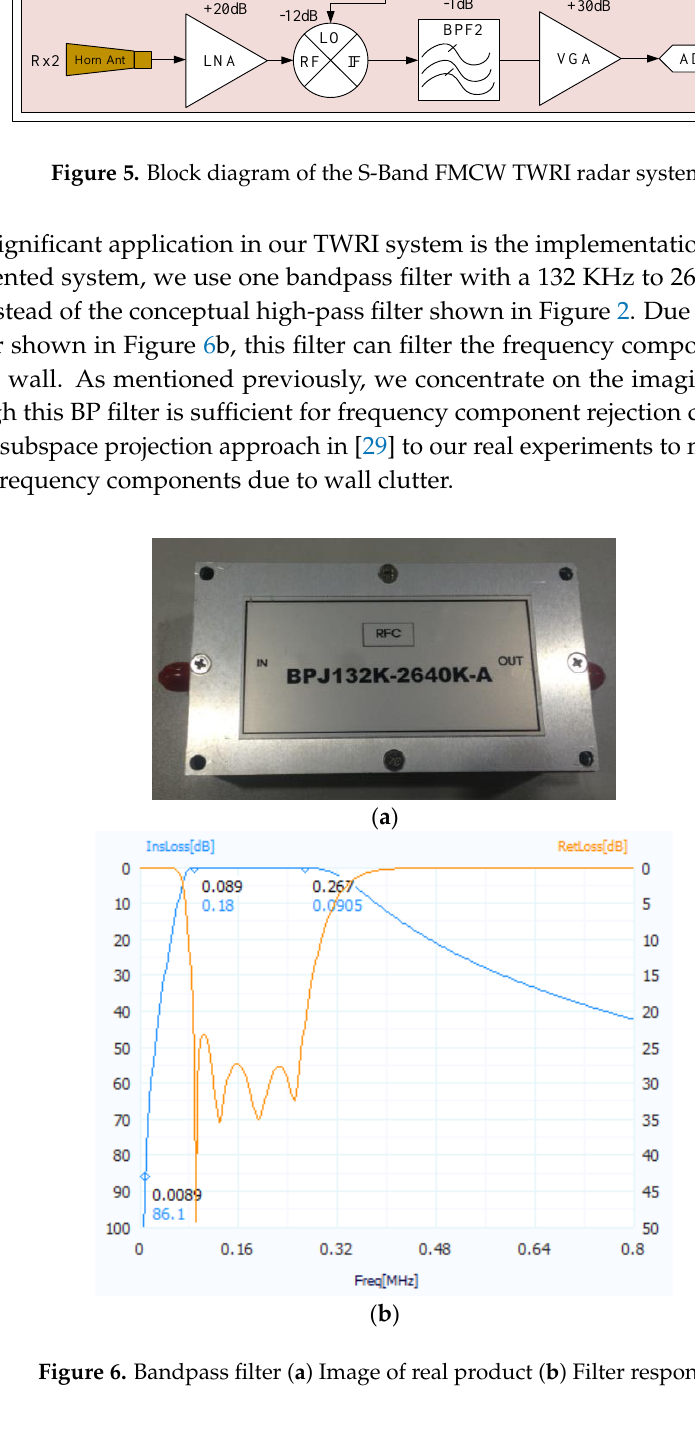
( b ) Figure 6. Bandpass filter ( a ) Image of real product ( b ) Filter response. Three identical standard horn antennas with 10 dB gain were employed in our implemented system, one for Tx (Back-end) and the others for Rx 1 and Rx 2 (Front-end), respectively. The outline and beam patterns of the standard horn antennas are illustrated in Figure 7a. The three centers of the antennas are assigned with equivalent distances of 12 cm, as show in Figure 7b.